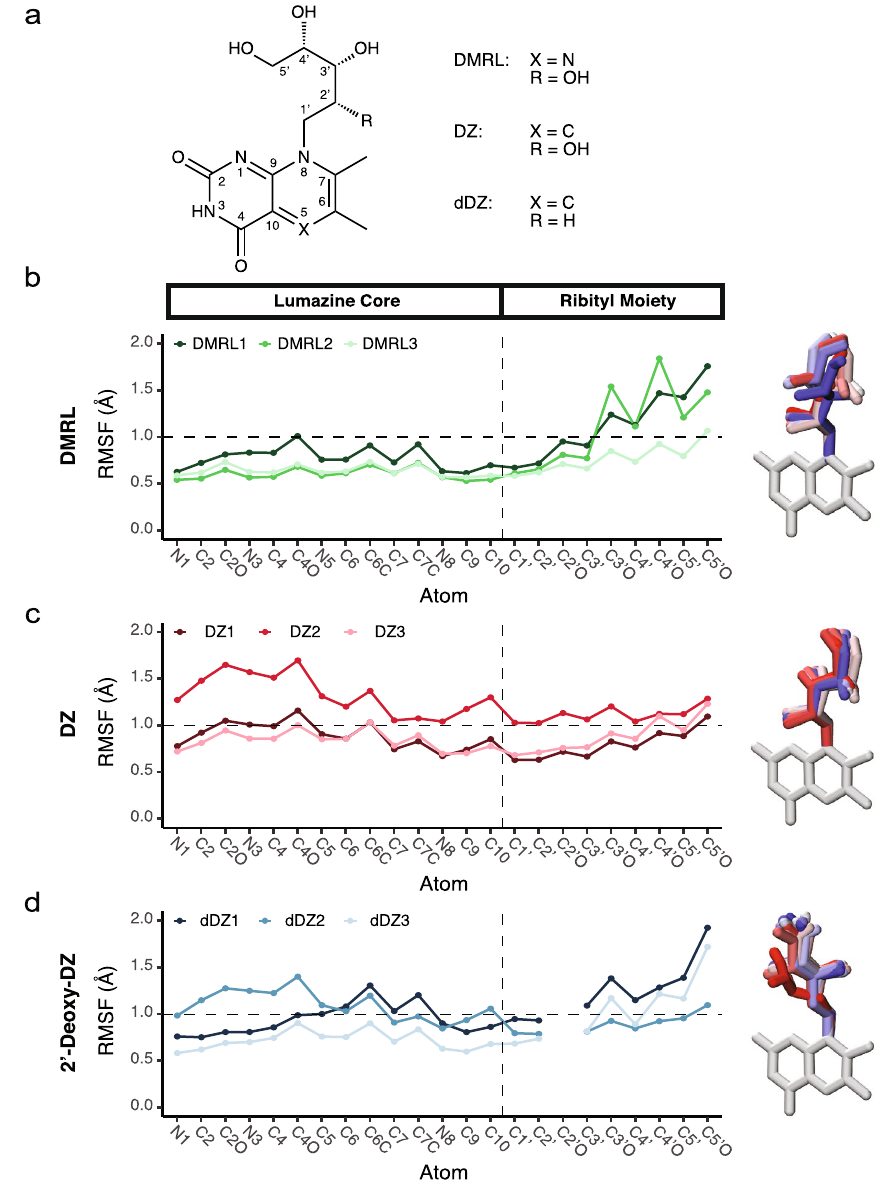
Figure 8. Molecular dynamics simulations of DZ, 2 ′ -deoxy-DZ, and DMRL ligands docked to MR1 identify differential flexibility of each ligand within the binding pocket. ( a ) Chemical representation of DMRL and its derivatives; numbering of adduct atoms is relative to the core atoms (i.e. the methyl group on carbon 7 is named “C7C” and the 3 ′ hydroxyl is referred to as “C3 ′ O”). ( b – d ) Left panels show RMSF calculations (indicative of ligand dynamics) for each simulation replicate over the course of each 80 ns MD simulation for DMRL ( b ), DZ ( c ) or 2 ′ -deoxy-DZ (dDZ) ( d ). The horizontal line at 1 Å does not represent any parameter; it only serves as a visual guide to compare across plots. Right panels show visualization of dynamic states adopted by the ribityl chain in a representative simulation for each ligand (simulations DMRL2, DZ1, and dDZ1), evolving from red to blue across